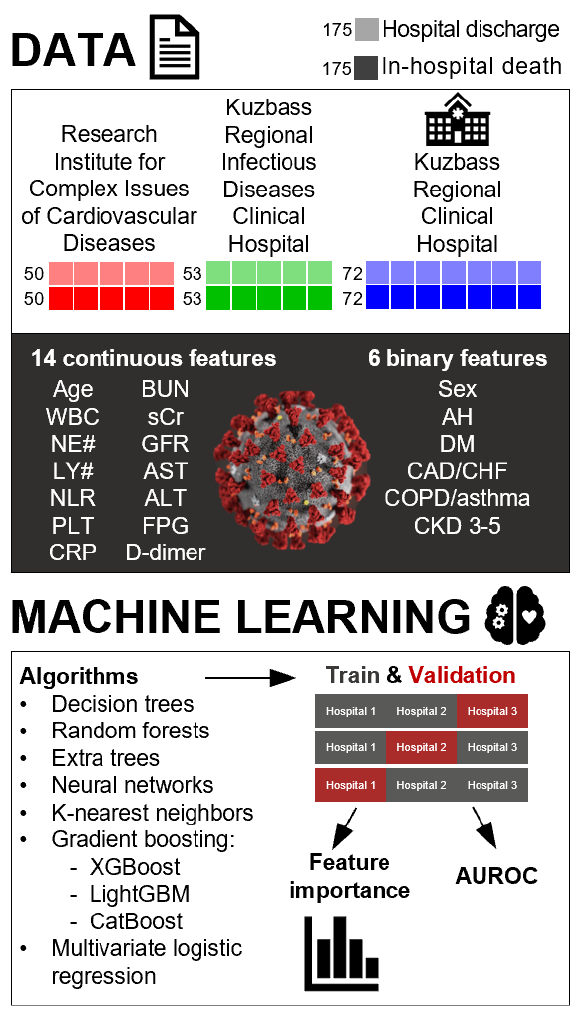
Figure 1. Study design. The patients ( n = 350) enrolled from three centers (Research Institute for Complex Issues of Cardiovascular Diseases, n = 100; Kuzbass Regional Infectious Diseases Clinical Hospital, n = 106; Kuzbass Regional Clinical Hospital, n = 144) have been pre-matched (1:1) by age, sex (male or female), and outcome (in-hospital death or hospital discharge). This patient dataset has been employed for the ML by a number of algorithms (decision trees, random forests, extra trees, neural networks, k-nearest neighbors, gradient boosting: XGBoost, LightGBM, and CatBoost) and multivariate logistic regression as a reference. In total, we assessed 14 continuous variables (age, WBC, NE#, LY#, NLR, PLT, BUN, sCr, GFR, AST, ALT, FPG, CRP, and D-dimer) and 6 binary variables (sex and past/present medical history of AH, DM, CAD/CHF, COPD/asthma, and stage 3–5 CKD) which were measured at the admission to the ICU. The outcome was binary (in-hospital death or hospital discharge). ML and cross-validation were performed either on a general dataset (70:30 learning:cross-validation samples proportion) or on all combinations of two sub-datasets from separate hospitals (Research Institute for Complex Issues of Cardiovascular Diseases and Kuzbass Regional Infectious Diseases Clinical Hospital, n = 206; Research Institute for Complex Issues of Cardiovascular Diseases and Kuzbass Regional Clinical Hospital, n = 244; Kuzbass Regional Infectious Diseases Clinical Hospital and Kuzbass Regional Clinical Hospital, n = 250) using the third dataset (Kuzbass Regional Clinical Hospital, n = 144; Kuzbass Regional Infectious Diseases Clinical Hospital, n = 106; Research Institute for Complex Issues of Cardiovascular Diseases, n = 100, respectively) as a cross-validation sample. The efficiency of the ML algorithms and tools was evaluated by AUROC, percent of correct predictions (%sensitivity and %specificity), and the range of these parameters between the distinct study centers.